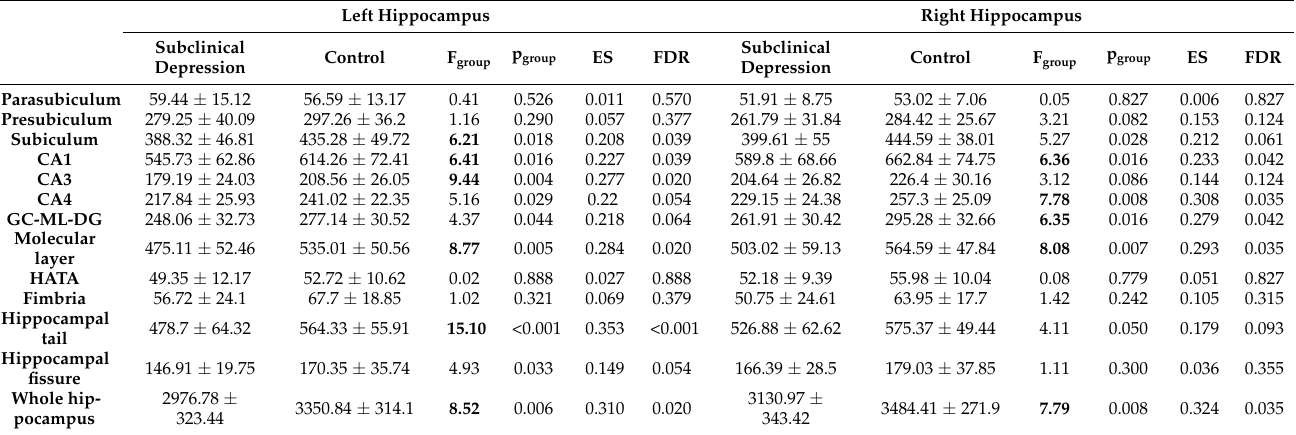
Table 2. Volume of hippocampal subfields.